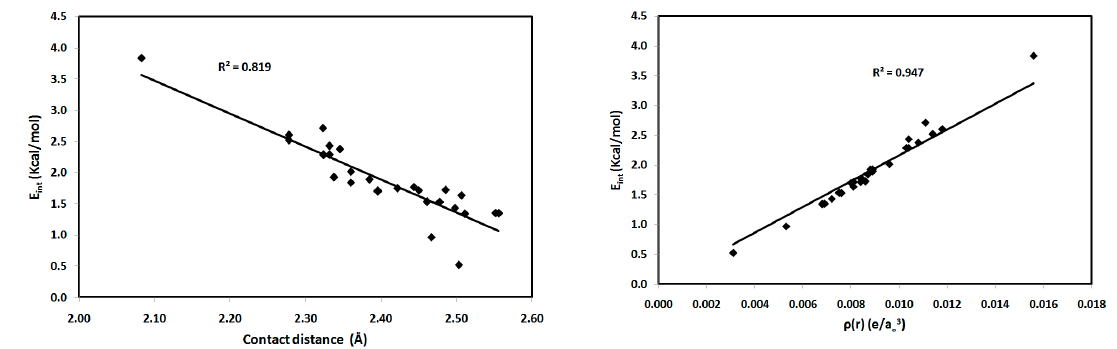
Figure 9. Interaction energies ( E int ) versus contact distances (left) and electron density ( ρ (r)) (right) for the studied systems.